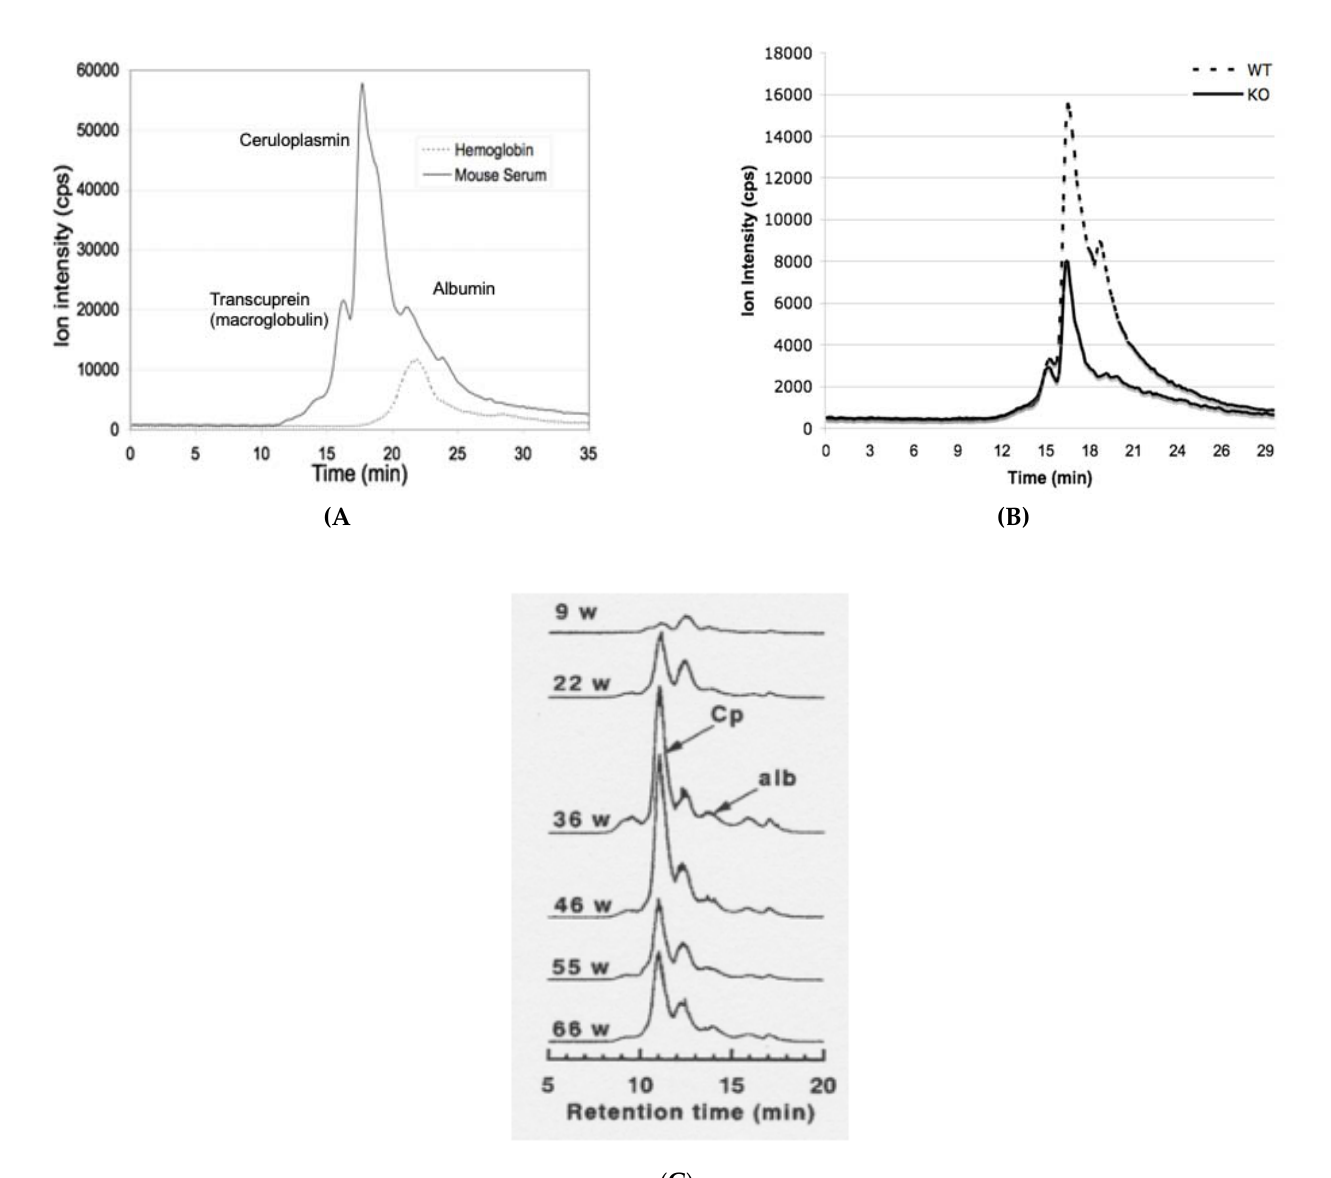
Figure 2. Examples of elution of plasma copper ‐ binding components in large pore size exclusion chromatography detected by tandem ICP ‐ MS, identifying peaks attributable to ceruloplasmin and some other known copper carriers. The x ‐ axis shows elution over time (min); the y ‐ axis is the content of 63 Cu obtained by mass spectrometry as signal intensity of the ion, counts per second (cps). ( A , B ) Biosep 4000 HPLC, also showing mouse serum and the elution of hemoglobin standard, on the left ( A ), and on the right ( B ) mouse serum from normal wildtype mice (WT; dashed line) as well as mice where the ceruloplasmin gene has been knocked out (KO; solid line). The figure in ( A ) modified from one in Cabrera et al. [23]; figure ( B ) is reprinted with permission from Gray et al. [24]. For both, copper profiles were averages for two WT plus or minus three KO mice. Knocking out ceruloplasmin reduced the signal 35%, indicating that ceruloplasmin accounted for 65% of the total serum copper. ( C ) GS ‐ 520 HPLC, showing Cu components in serum of Long ‐ Evans Cinnamon (LEC) rats at different ages, in weeks (w), reprinted with permission from Komatsu et al. [25]. This figure was included to further illustrate that there are many copper binding components other than ceruloplasmin in the blood plasma. The article from which it comes investigated how mutations in the copper transporter (ATP7B) of LEC rats and the resultant inflammation (which occurs in mid ‐ life in these rats) affect levels of ceruloplasmin ‐ copper in the blood. The figure shows that proportions of copper attributable to ceruloplasmin are highest during the inflammatory phase.